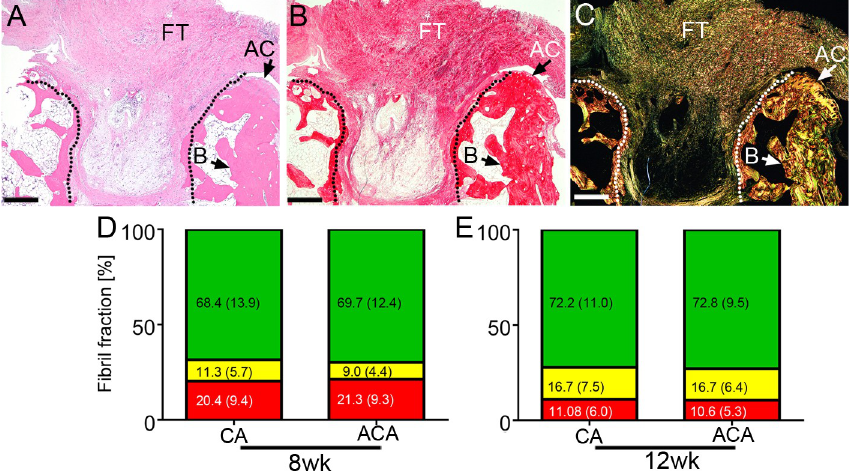
Fig 5. A histological assay of the pannus-like scar tissue formed in an osteochondral defect (delineated). The site of injury was stained with H&E (A) and with collagen-specific picrosirius red (B&C). The picrosirius red-stained samples were observed in normal light (B) and polarized light (C). Fibrotic tissue (FT), bone (B), and fragments of the articular cartilage (AC) are indicated. D&E, A summary of measurement of the percentages of the green birefringence (GB) fibrils, yellow birefringence (YB) fibrils, and red birefringence (RB) fibrils formed in the CA-treated and the ACA-treated rabbits. Corresponding segments of the bars include the means and standard deviations (in parentheses). Data for the 8wk and the 12wk groups are presented. Bars = 1